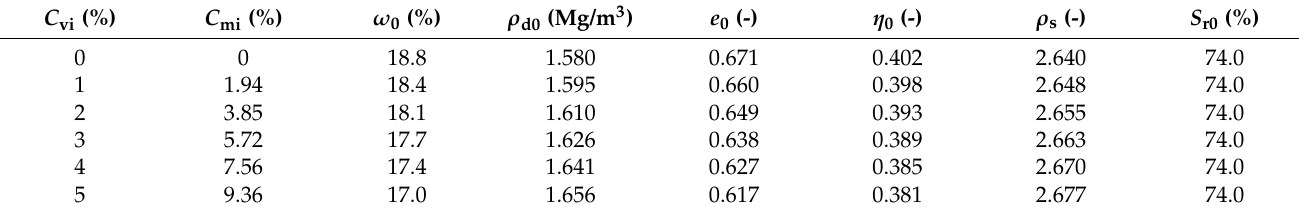
Table 2. Initial states of as-compacted untreated and cement-treated